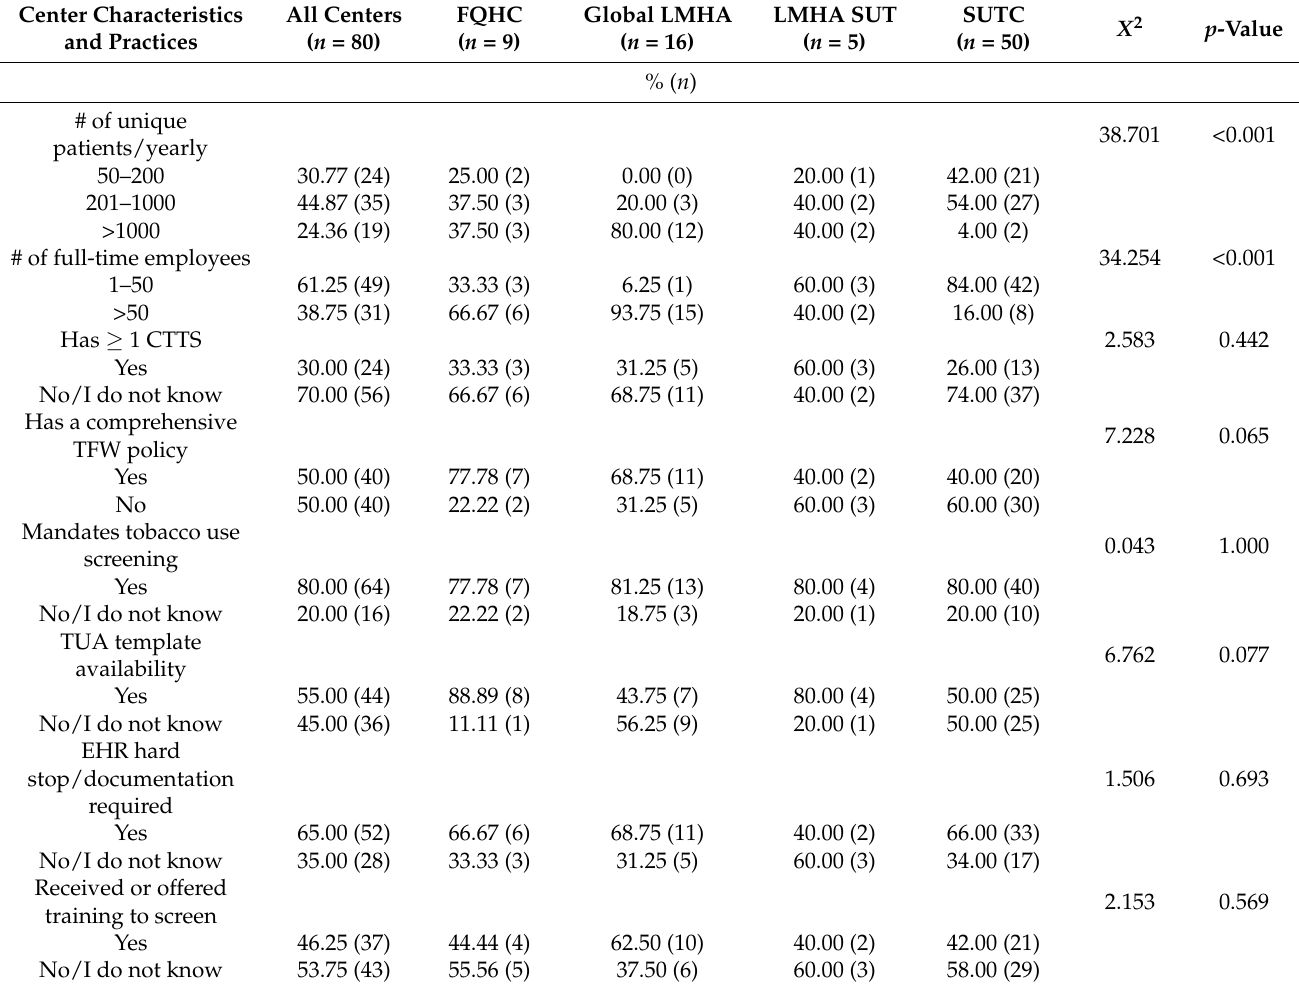
Table 1. Health Care Center Characteristics and Tobacco Use Screening Practices ( n =